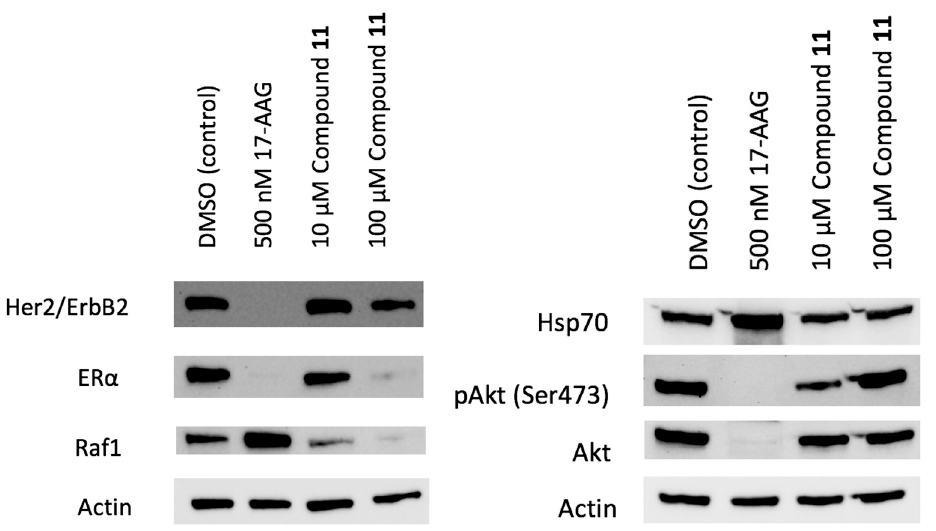
Figure 11. Representative Western blot analyses 24 h after treatment with 11 at concentrations of 10 and 100 µ M and 17-AAG at concentration 500 nM in MCF-7 cells vs. DMSO (vehicle, negative control). Marked and dose-dependent decreases of Hsp90 clients were observed without the significant induction of Hsp70 levels.